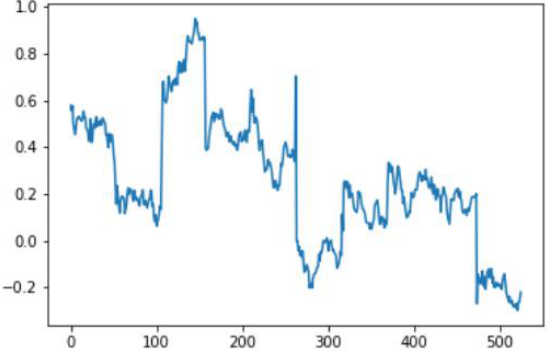
Figure 64. Merged orientation data ( y -axis).